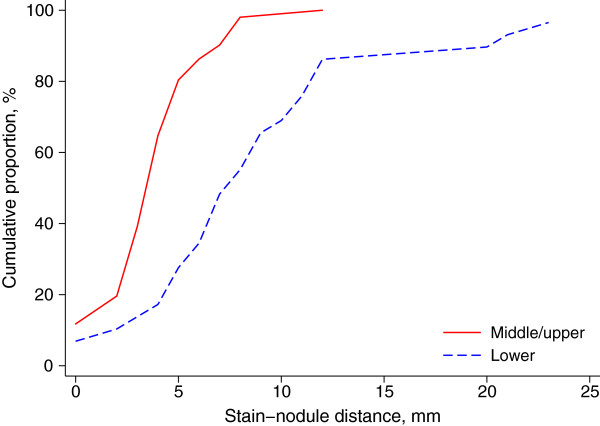
Cumulative distributions of stain-lesion distance for lesions on middle/upper versus those on lower lobes.